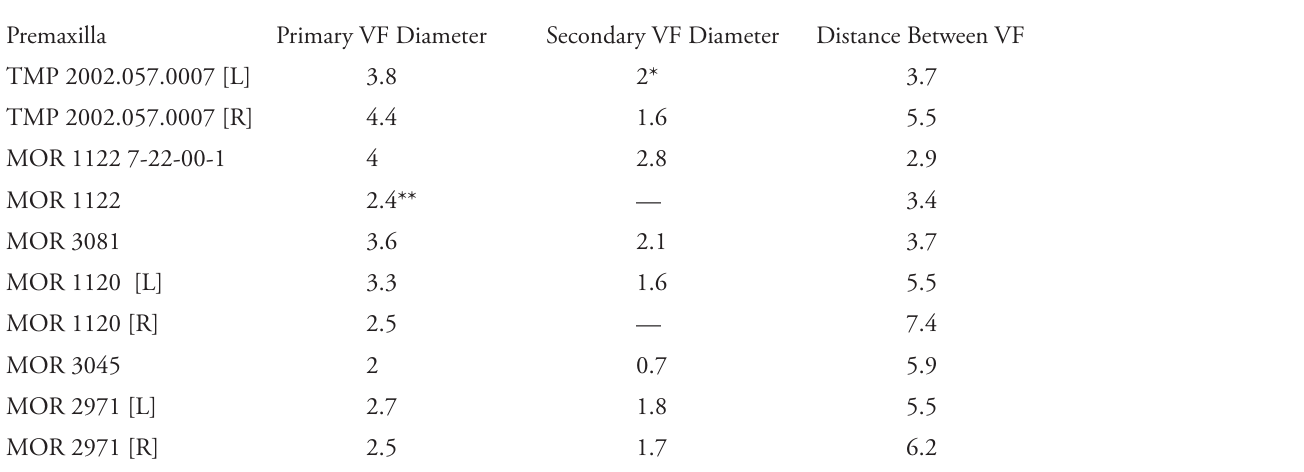
*The left premaxilla of TMP 2002.057.0007 exhibits a third small VF (1.7 cm diameter) just caudal to the secondary VF. **MOR 1122 skull VF (Fig. 9) are not fully